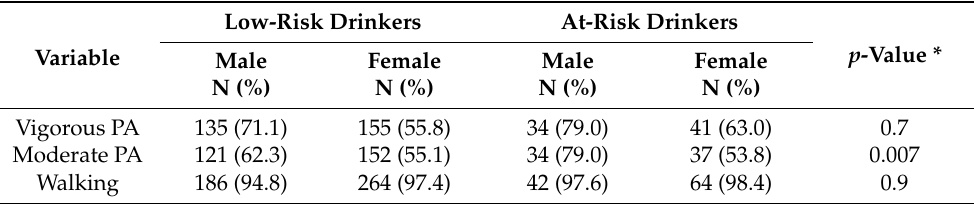
Table 7. Physical activity associated with alcohol consumption in medical